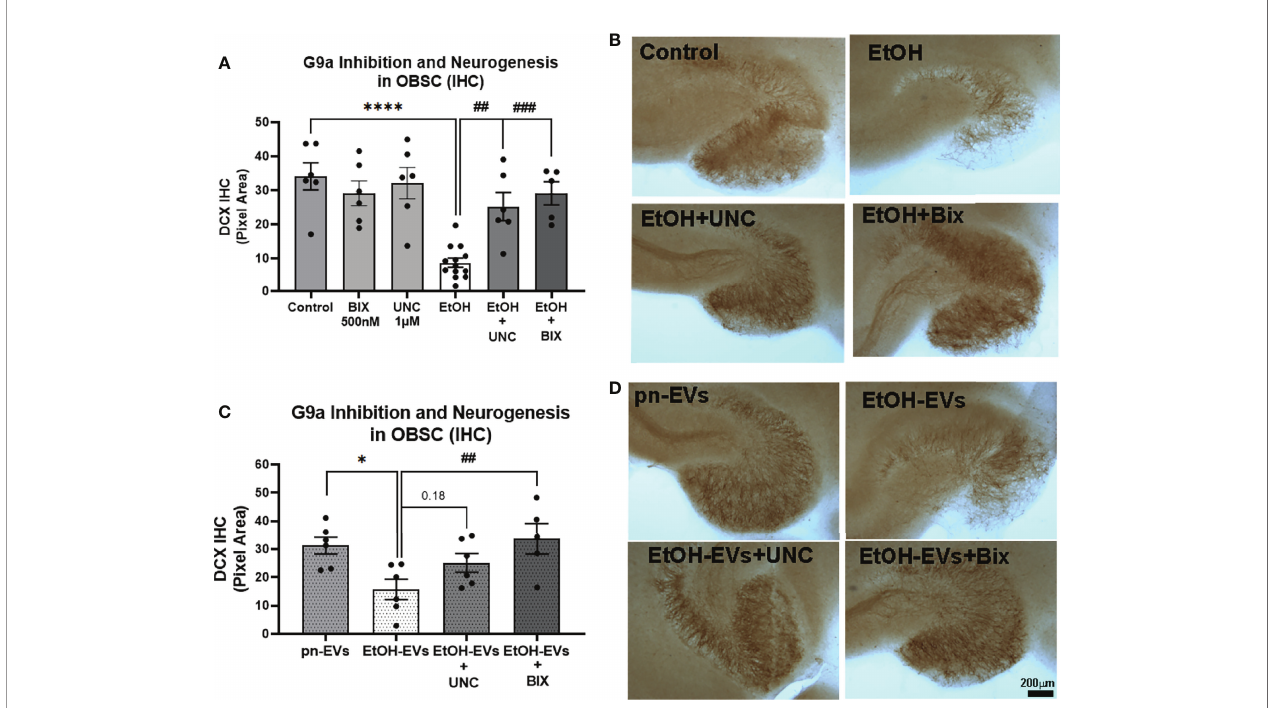
FIGURE 6 | Pharmacological inhibition of G9a prevents loss of neurogenesis caused by ethanol and EtOH-EVs. OBSCs were treated with either EtOH or EtOH-EVs +/- G9a inhibitors BIX-01294 (BIX) or UNC0642 (UNC). Neurogenesis was measured by IHC for DCX. (A) EtOH caused a 74% reduction of DCX that was prevented by UNC (1µM) and BIX (500nM). 1-Way ANOVA, F 13,68 = 6.8, ****p < 0.0001 vs. control, ## p < 0.01 and ###p < 0.001 vs. EtOH, Sidak ’ s post-hoc multiple comparison ’ s test. (B) Representative images show loss of neurogenesis with EtOH that was prevented by G9a inhibitors. (C) pn-EVs increased DCX by 37%, while EtOH-EVs caused a 50% reduction in DCX relative to control pn-EVs. One-way ANOVA, F 4,23 = 4.05, * p < 0.01 vs. pn-EVs, ##p < 0.01 vs. EtOH-EVs, Sidak ’ s post-test. (D) Images showing G9a inhibitors blocked the loss of neurogenesis caused by